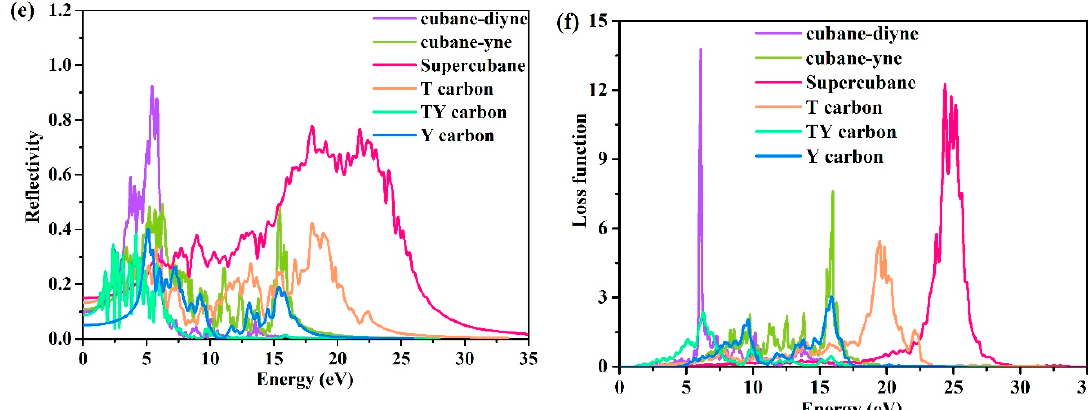
Figure 6. Calculated optical properties for the investigated carbon allotropes: Conductivity ( a ), dielectric function ( b ), refractive index ( c ), absorption coefficient ( d ), optical reflectivity spectrum ( e ) and loss function ( f ).